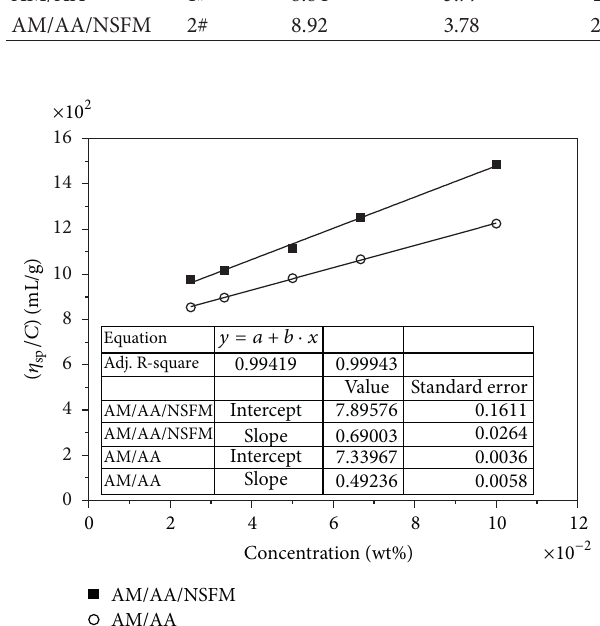
/𝐶 versus 𝐶 relationships of AM/AA and AM/AA/ sp